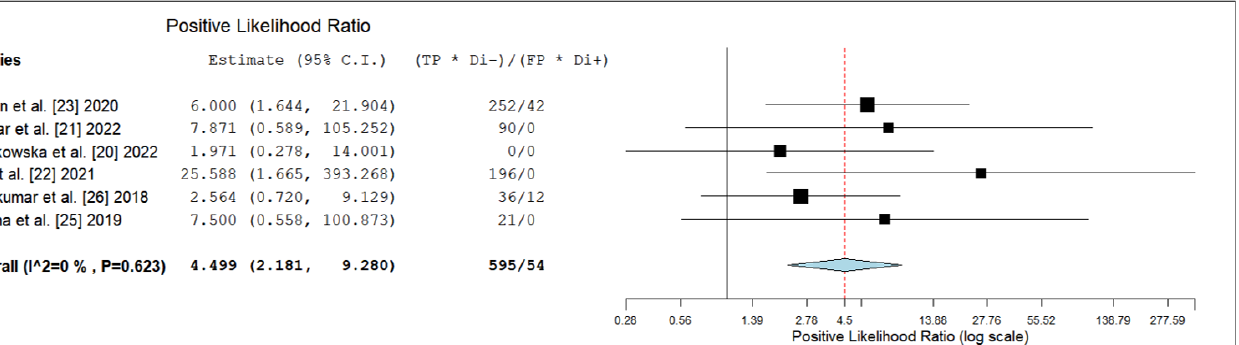
Figure 3. Summary ROC curve of diagnostic accuracy of the index test in high-grade glioma. The pooled LR+, LR- and DOR were 4.5 (95% CI: 2.2 – 9.3), 0.07 (95% CI: 0.04 – 0.15) and